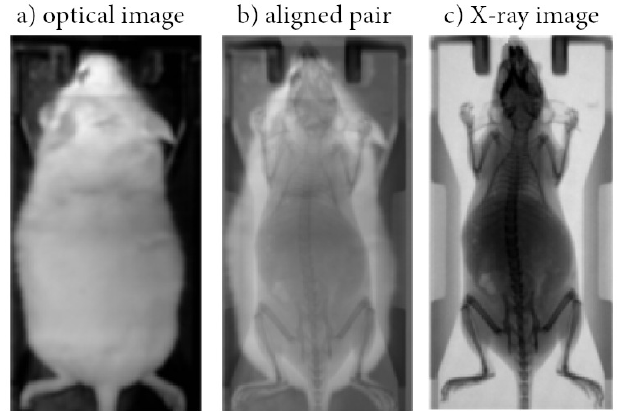
Figure 1. Indicative optical image acquired using a conventional photographic sensor located in BIOEMTECH eye’s series radioisotope screening tools ( a ); Indicative X-ray image acquired in a prototype PET/SPECT X-ray system ( c ) used as ground truth; Aligned pair ( b ).